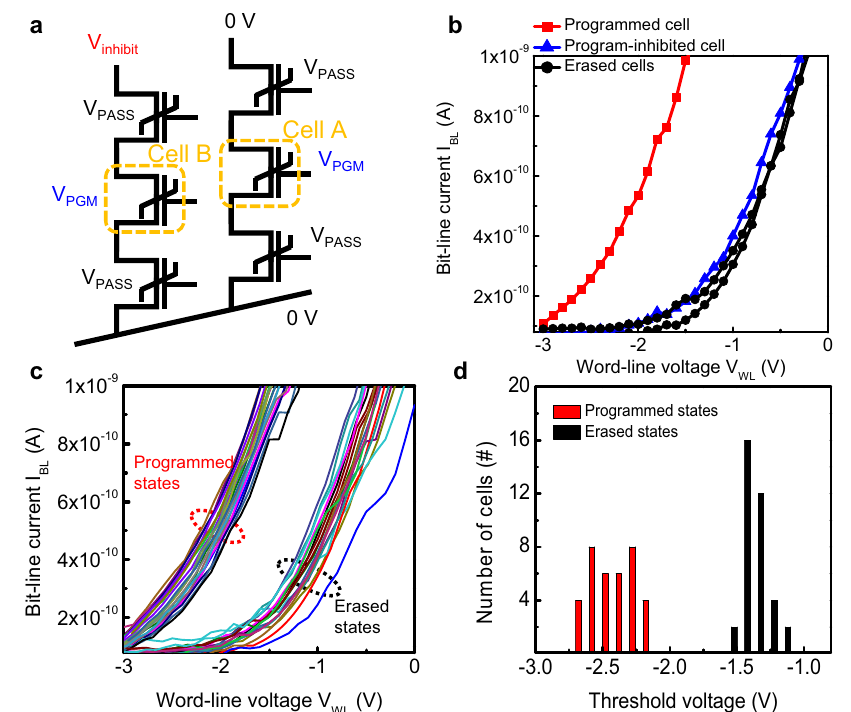
Fig. 2 | Operation characteristics of 3D FeNAND. a Equivalent circuits of 3D FeNAND and program operation. V PGM , V PASS , and V inhibit stand for program, pass, andinhibitvoltages,respectively. b I BL – V WL curvesoftheselectedmemorycelland WL-sharing memory cell after erase and program operations. The program of the WL-sharing memory cell is prevented by the program-inhibit operation. The